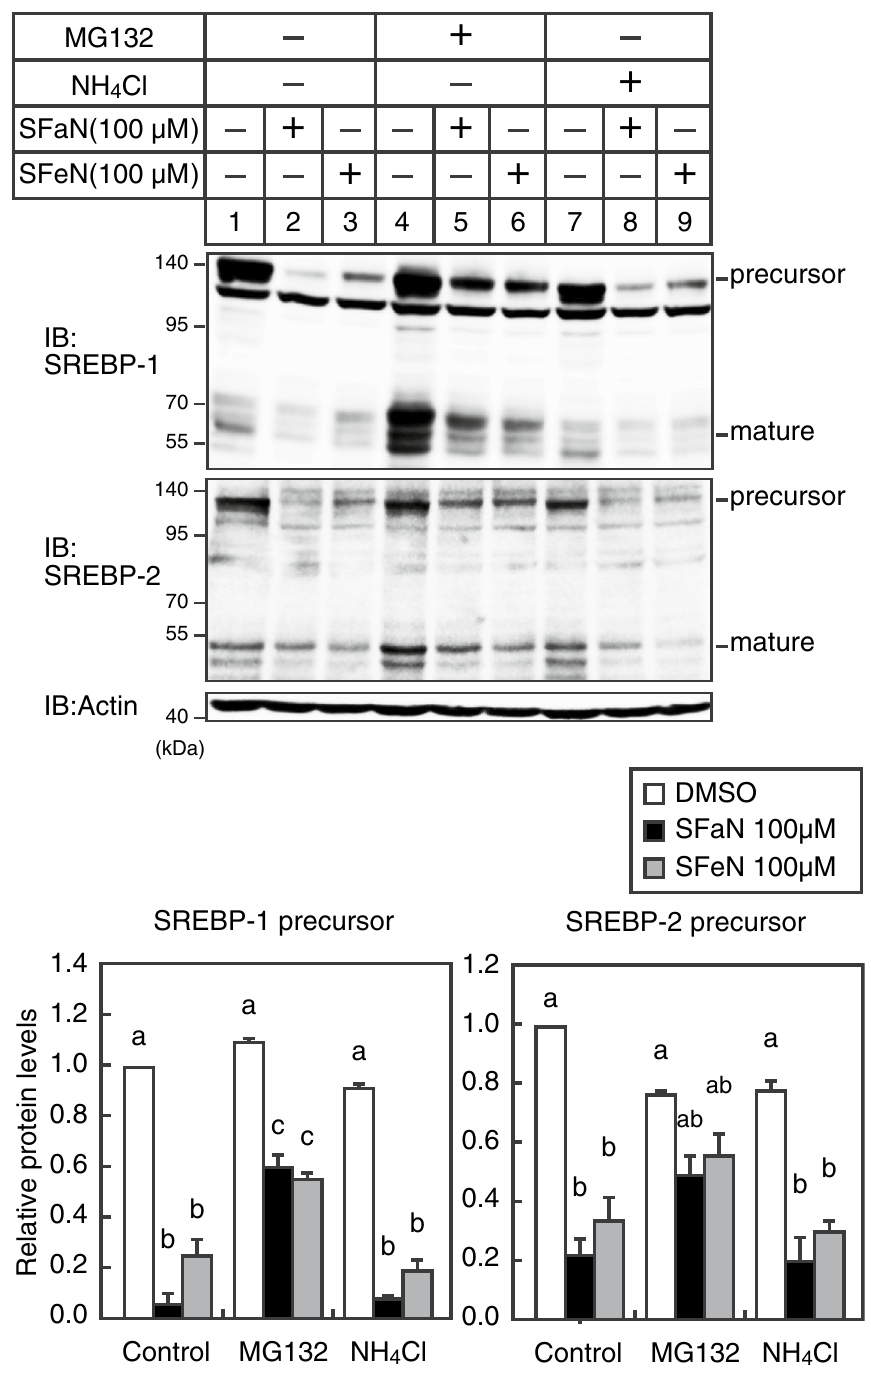
Figure 6. SFaN promotes the ubiquitin–proteasome pathway-mediated SREBP precursor degradation. Huh-7 cells were incubated in medium D for 16 h. After incubation with 10 μM MG132 or 20 mM NH 4 Cl for 30 min, the cells were shifted into medium E supplemented with 10 μM MG132 or 20 mM NH 4 Cl in the presence of the vehicle, 100 μM SFaN or SFeN. After incubation for 3 h, whole-cell extracts underwent immunoblotting (IB) with anti-SREBP-1 (2A4), anti-SREBP-2, or anti-β-actin antibodies. The signal intensities (n = 3) were quantified using Image J and normalized to that of β-actin. The signal intensity of the control group treated with DMSO was arbitrarily defined as one. All data are expressed as means ± S.E. Different superscript letters denote statistical significance (p < 0.05). Full-length images of all replicates are presented in Supplementary Fig.